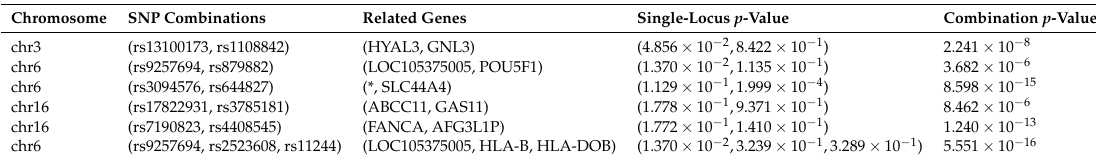
Table 1. Significant two-locus and three-locus combinations identified by ClusterMI on the Wellcome Trust Case Control Consortium (WTCCC) breast cancer (BC) data.